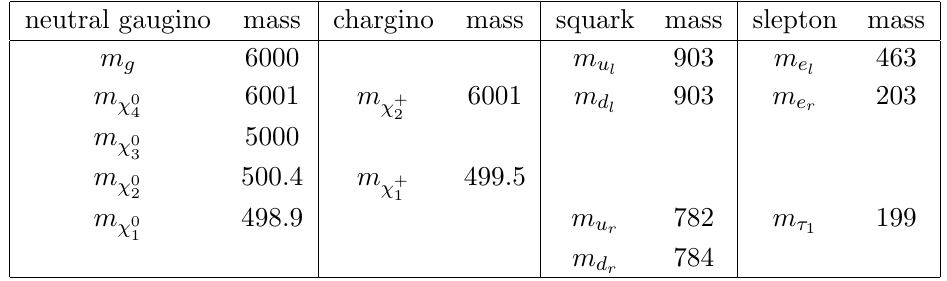
Table 1 . A benchmark antisplit SUSY spectrum with heavy squarks, intermediate mass Higgsino, and stau NLSP.